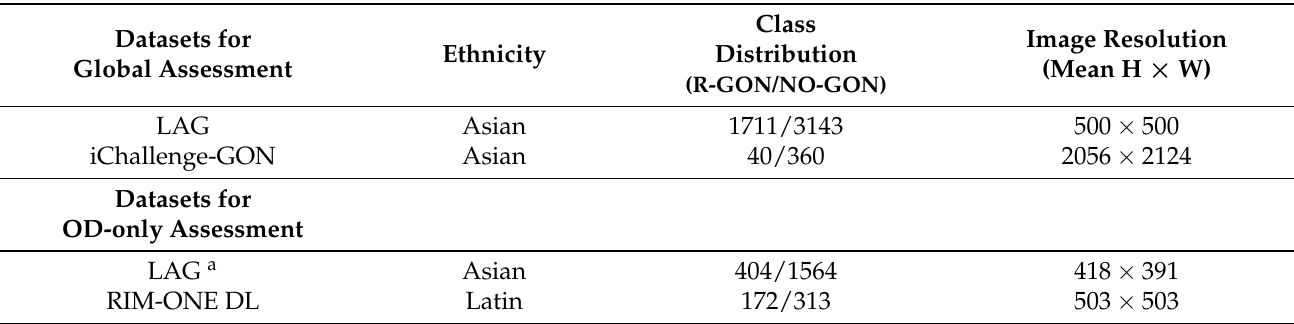
Table 2. CFP datasets specifications employed for Training, Validation, and Test procedures related to ensemble-based CAD system.